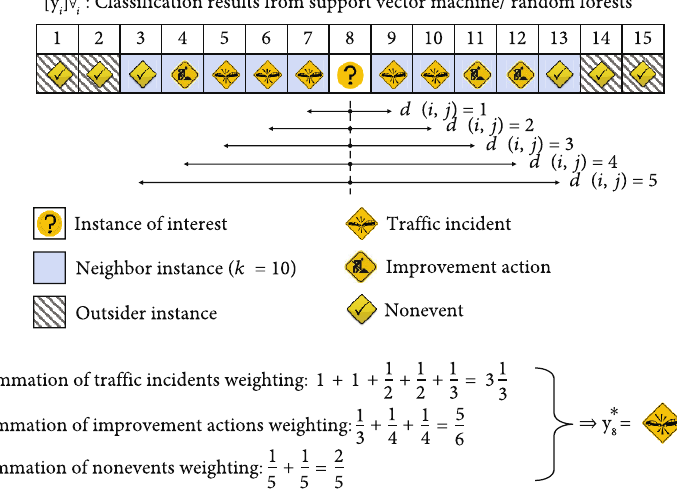
Figure 3: Re fi ning classi fi cation of a data record through K-Nearest